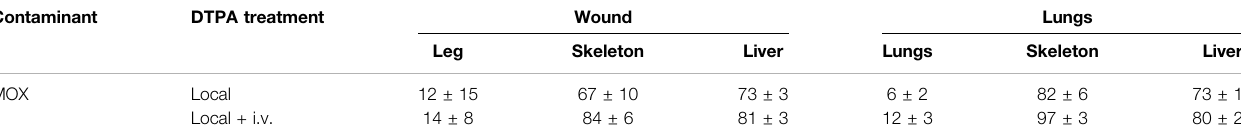
TABLE 2 | Reduction of tissue activity levels by local or combined local and systemic DTPA treatment following MOX contamination.